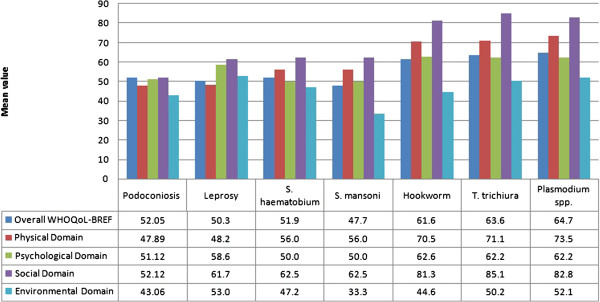
Comparison of WHOQoL-BREF scores for different diseases [[19],[46]].